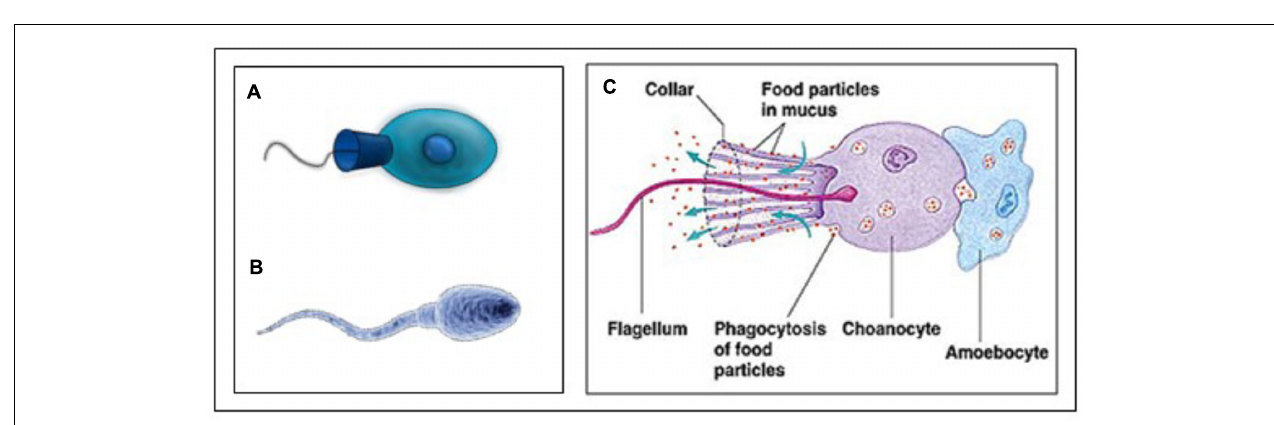
FIGURE 9 | (A) Animal Choanoflagellate organism (Urutseg as original author (2009), licensed Under Creative Commons Attribution) and (B) Human spermatozoon: Google images, Kissping. Publicly available. (C) More detailed representation of an animal Choanoflagellate. From Google images and The wonderful World of Animalia, http://www.bio.miami.edu/dana/160/160S13_13print.html. Copyright permission not required. With